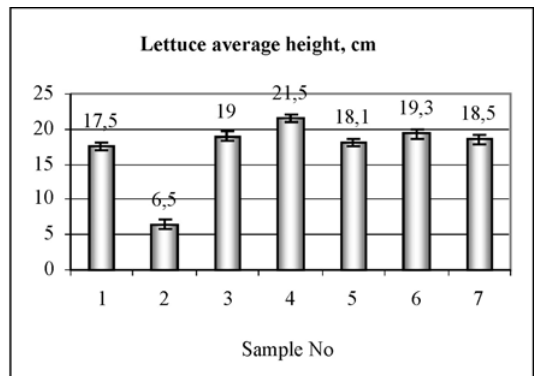
Fig 7. Lettuce average height in substrates of different compositions: 1 – peat substrate; 2 – soil; 3 – soil and sewage sludge 3:1; 4 – soil and sewage sludge 3:1 and 1,0 g K 2 SO 4 ; 5 – soil and sewage sludge 1:1; 6 – soil and